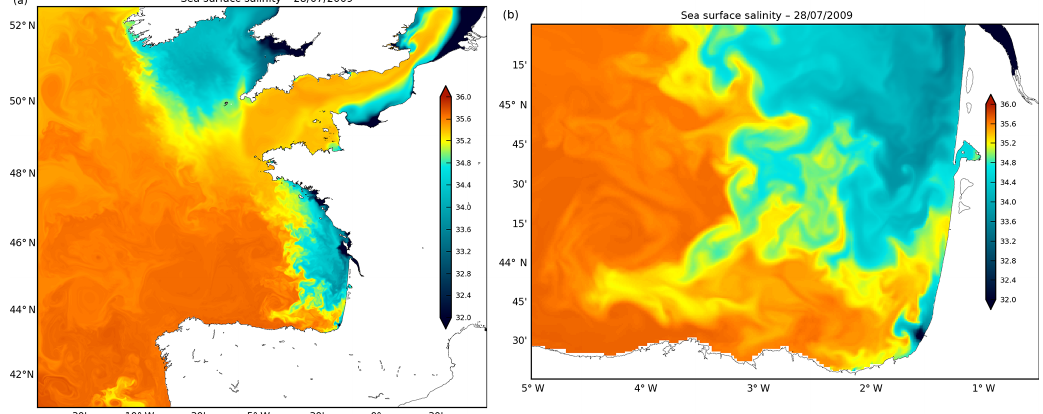
Figure 4. Sea surface salinity (28 July 2009) during an event of freshwater export in the open ocean as described by Reverdin et al. (2013). Panel (a) represents the full model domain and (b) is focused on the south-eastern part of the Bay of Biscay to highlight the freshwater export around 44 ◦ N and 3.5 ◦